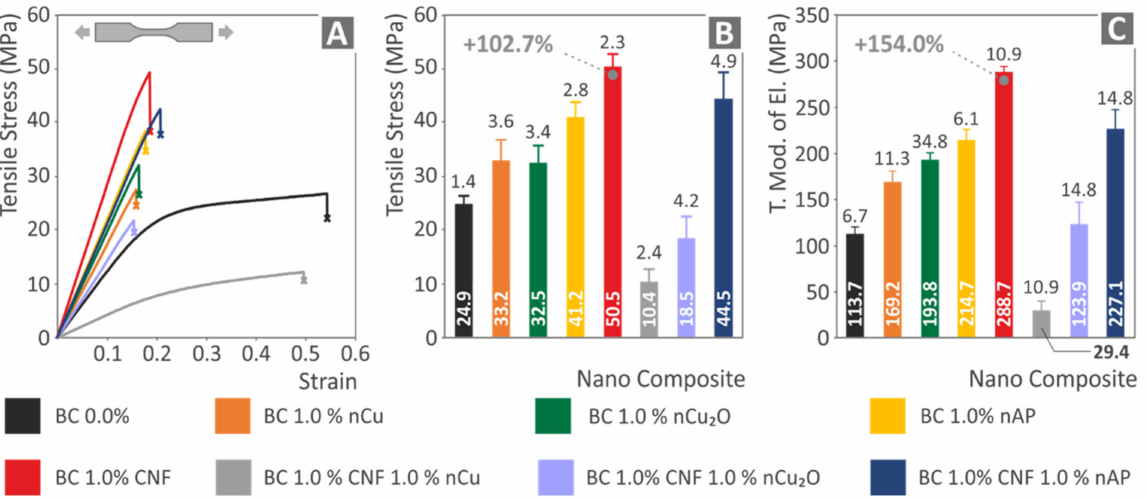
Figure 11. Tensile test results: ( A ) typical stress (MPa) vs. strain (mm/mm) graphs for all materials. ( B ) Average tensile strength (MPa) and deviation for all materials. ( C ) Average tensile modulus of elasticity and deviation for all